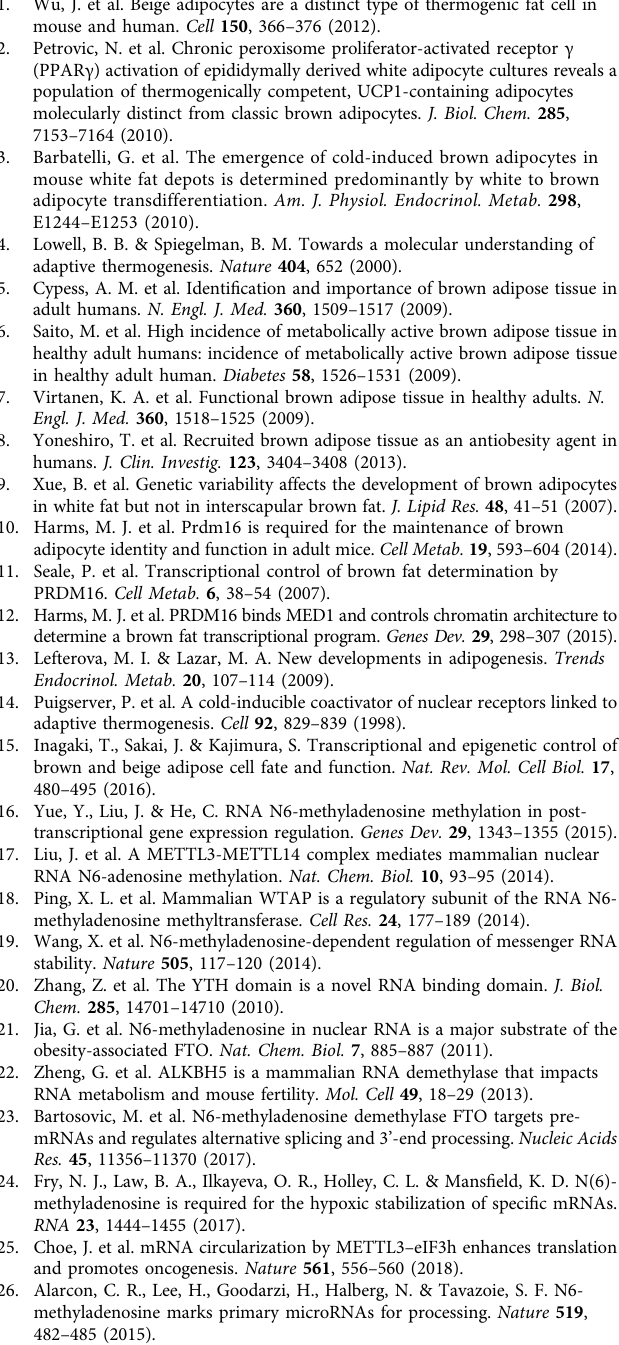
Quanti fi cation of mtDNA copy number . Total DNA was isolated from mouse brown adipose tissue. mtDNA was ampli fi ed using primers speci fi c for the mito- chondrial mtND1 gene and normalized to genomic DNA by ampli fi cation of the LPL nuclear gene. The primer sequences can be found in Supplementary Table